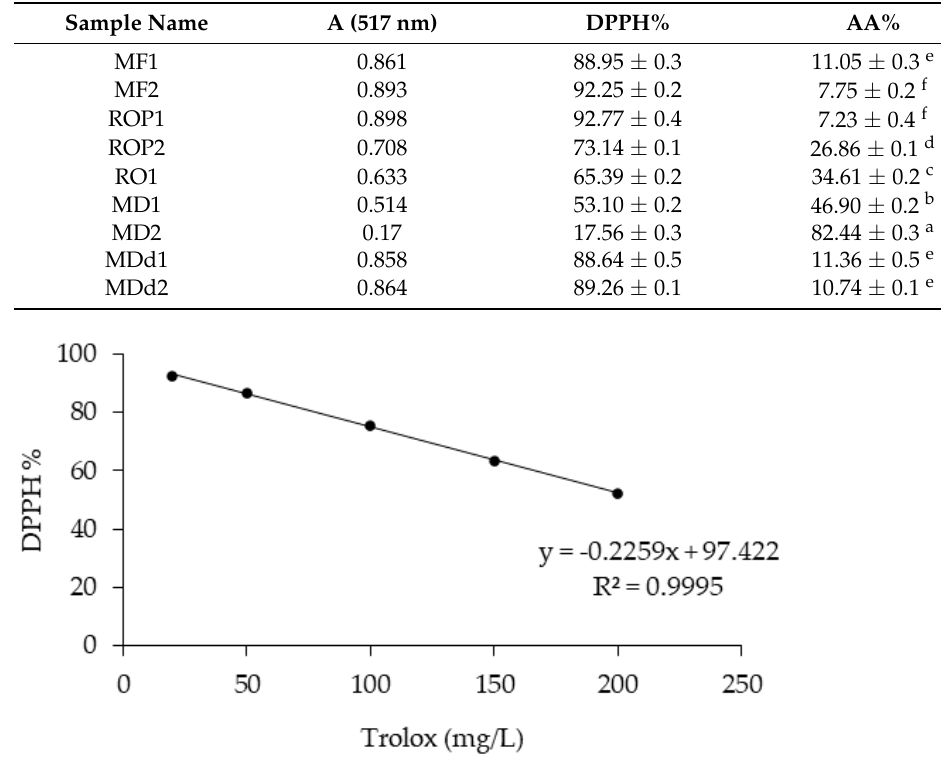
Table 3. Evaluation of antioxidant activity percent (AA%) using DPPH assay (mean value ± standard deviation (SD) of three independent experiments ( n = 3)). Numbers followed by different letters are statistically different at p < 0.001 (Tukey’s test).